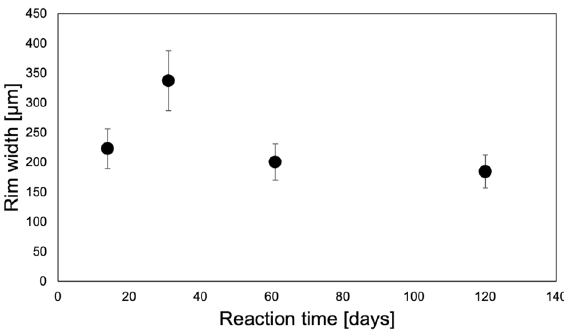
Figure 2. Reaction rim width as a function of time for CAR measured in SEM